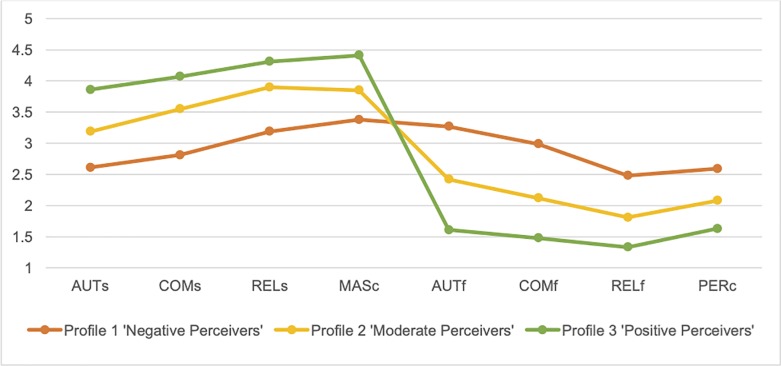
Graphic display of profiles based on eight motivational factors.AUTs = Autonomy satisfaction; COMs = Competence satisfaction; RELs = Relatedness satisfaction; MASc = Mastery Climate; AUTf = Autonomy frustration; COMf = Competence frustration; RELf = Relatedness frustration; PERc = Performance Climate.